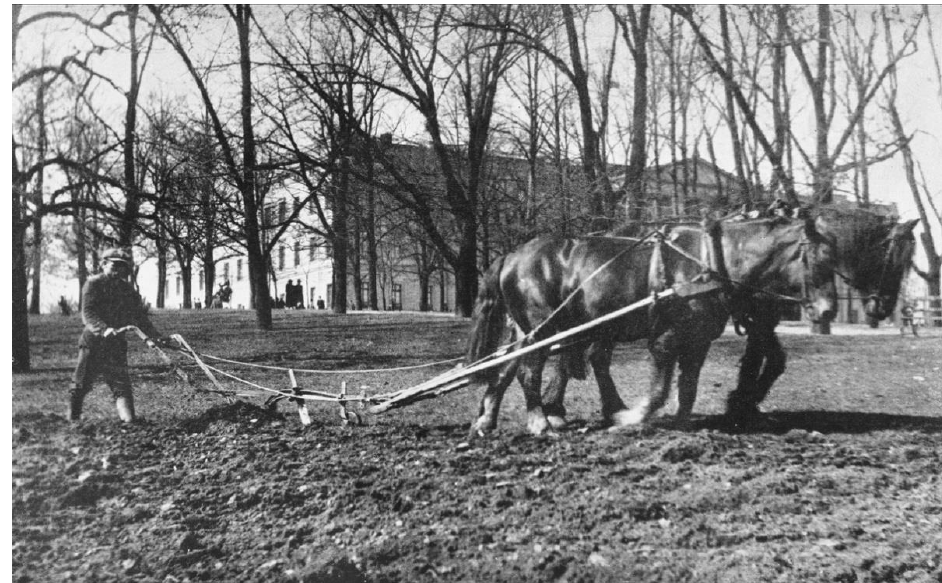
Figure 1. A photo documenting how the park area around the castle in central Oslo was used for food production during WWI (1917). Similar images are available, e.g., for Tiergarten in Berlin during WWII. Name of the photographer is unknown. Copyright: Oslo Museum (CC0 1.0 Univer- WWII. Name of the photographer is unknown. Copyright: Oslo Museum (CC0 1.0 sal).